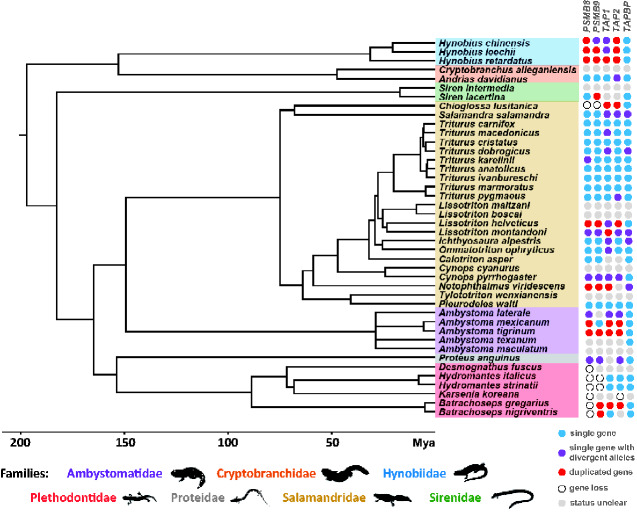
Phylogenetic tree of the species used in this study. Different colors define families. The right panel shows pattern of duplication of APGs. Blue circle indicates a single gene, whereas red circle designates a duplicated gene. Purple circle shows species with two different contigs for a gene but where three alleles were not detected in the read mapping. Empty circle indicates an apparent gene loss. Finally, gray circle indicates species in which only transcriptome assembly was available and there was no possibility to check number of alleles in the read mapping.